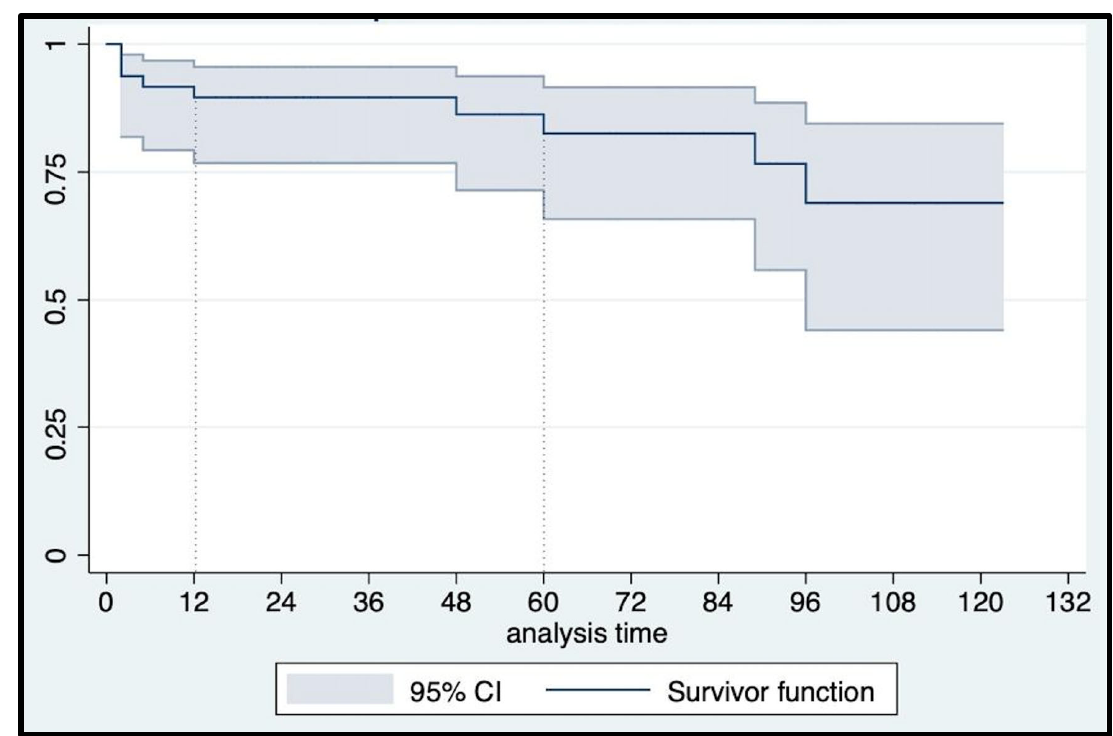
Figure 8. Kaplan–Meier overall erosion ‐ free survival curve.